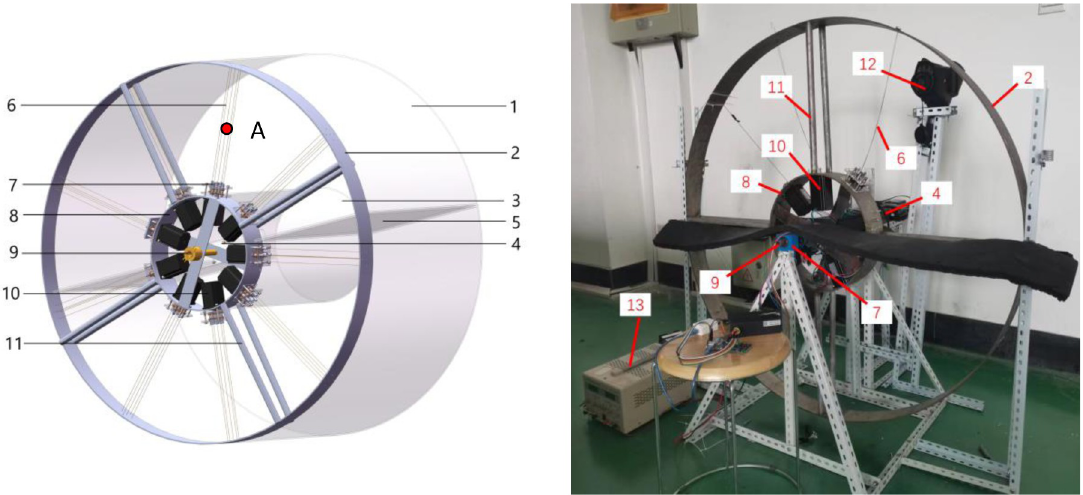
Fig 1. Experimental device of a novel continuous torsional refrigeration system. (a) Schematic Diagram of the Experimental Device. (b) Photo of the Experimental Device. 1—Motor Side External Insulation Layer, 2—Outer Wheel, 3—Insulation Shell, 4—Servo Motor, 5 —Heating and Cooling Area Partition, 6—Nitinol Wire, 7—Planetary Gearing, 8—Inner Wheel, 9—Central Shaft, 10—Stepping Motor, 11—Connecting Rod, 12—Infrared Thermal Imager, and 13—DC-regulated